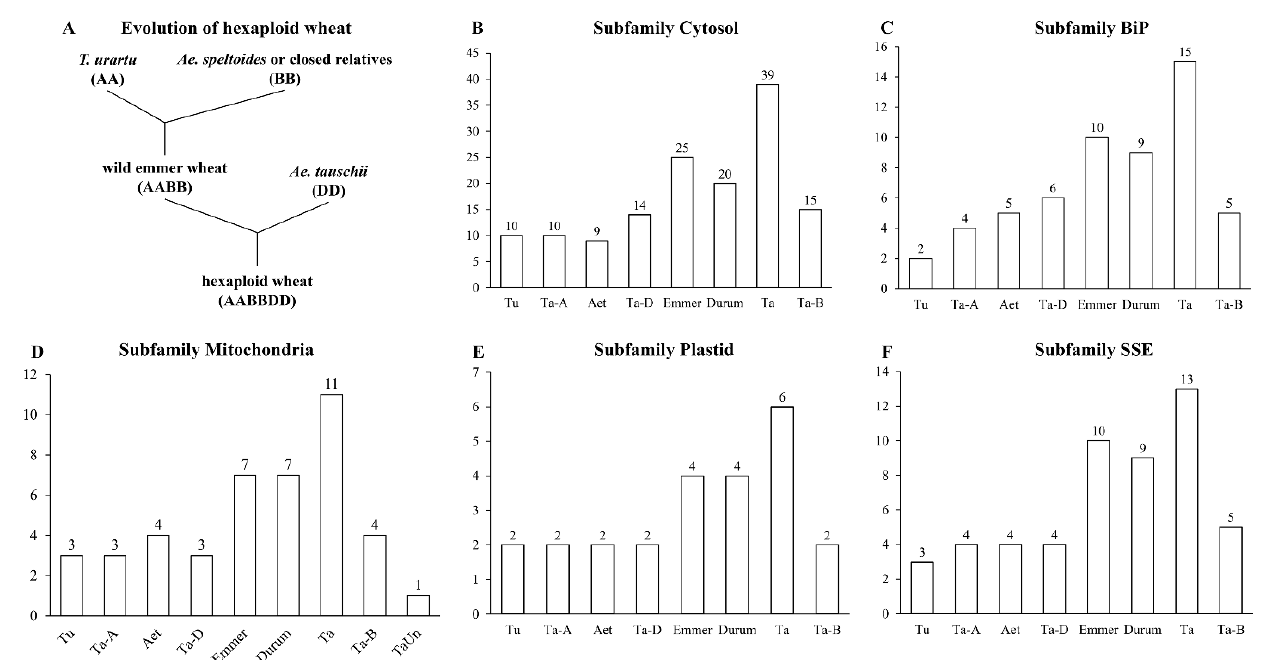
Figure 2. Distribution of HSP70s in wheat relatives: ( A ) evolution model of hexaploid wheat; ( B – F ) number of HSP70s in different subfamilies in different species and subgenomes. Aet, Ae. Tauschii ; Ta, hexaploid wheat; Emmer, wild emmer wheat; Durum, durum wheat; Tu, T.urartu ; Ta-A, A subgenome of hexaploid wheat; Ta-B, B subgenome of hexaploid wheat; Ta-D, D subgenome of hexaploid wheat.